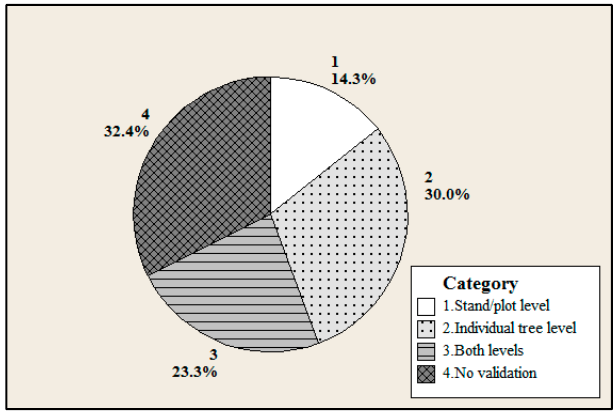
Figure 7. Summary of validation in ITCD and related research ( N = 210).